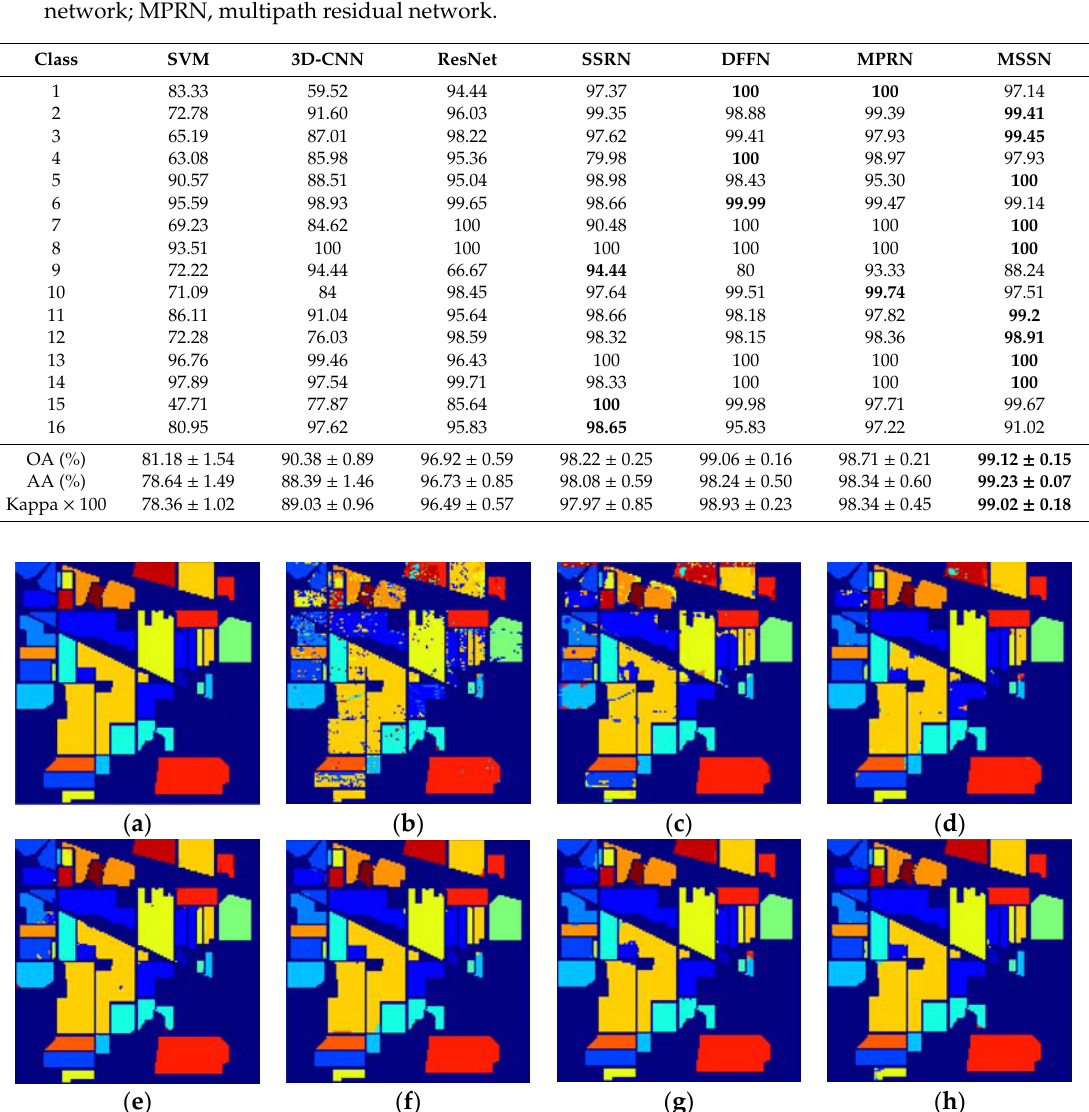
Figure 9. Classification maps for the Indian Pines data set. ( a ) Ground truth. ( b ) SVM. ( c ) 3D-CNN. ( d ) ResNet. ( e ) SSRN. ( f ) DFFN. ( g ) MPRN. ( h ) MSSN.